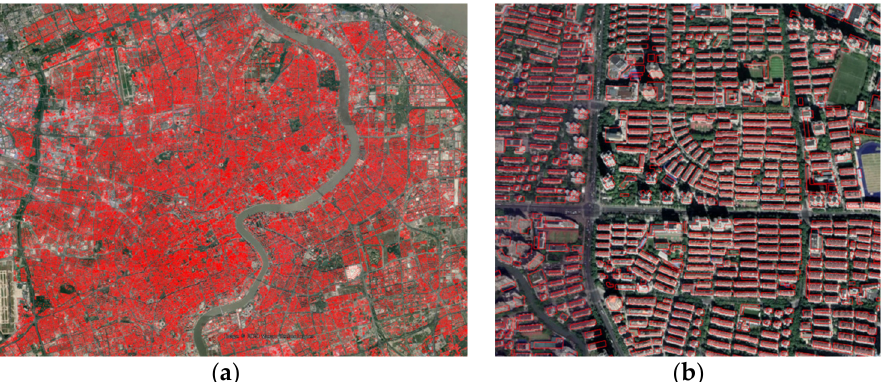
Figure 2. Examples of building footprints in: ( a ) Shanghai central city; ( b ) the enlarged image showing the details.